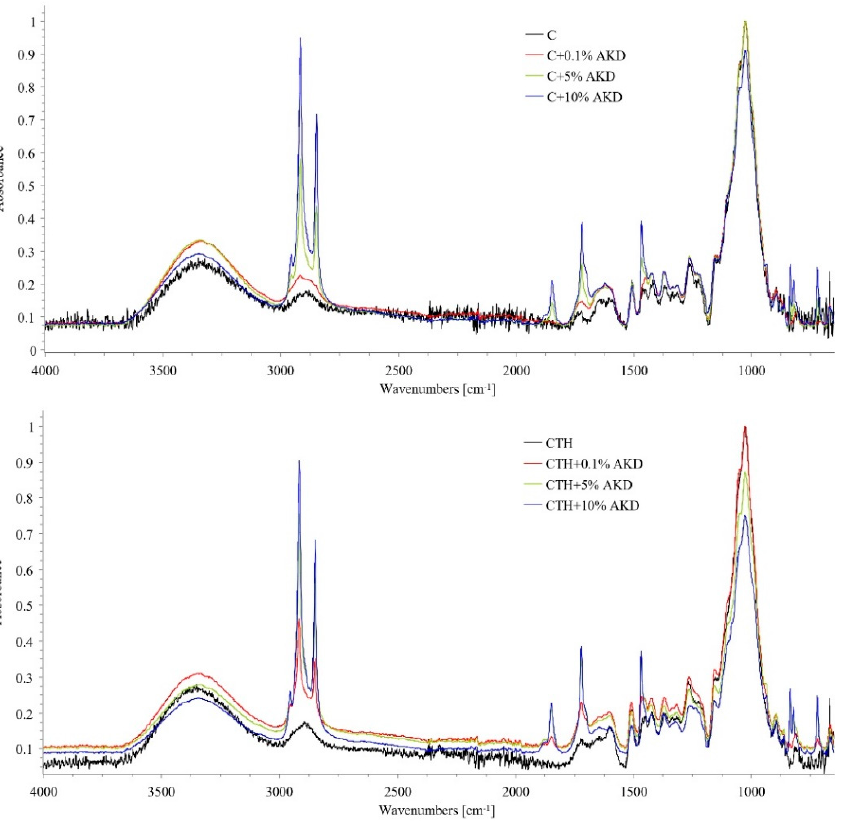
Figure 7. Comparison of FTIR spectra of unmodified ( top ) and thermally modified cedar wood samples ( bottom ) with AKD.